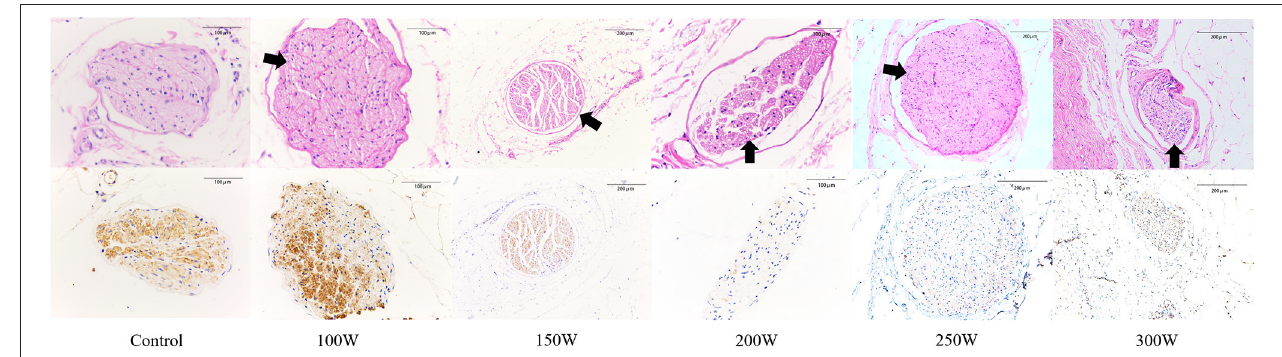
FIGURE 5 | Representative histological and immunohistochemical images of nerves in different groups at day 28. ( First row ) Representative images of nerves with hematoxylin and eosin (H&E) stain. ( Second row ) Corresponding images of nerves stained by anti-tyrosine hydroxylase (TH) enzyme. Black arrow indicates the vacuolization and pyknotic nuclei in nerves.